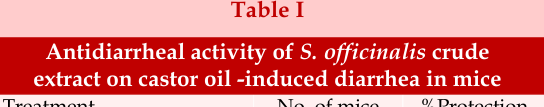
Antidiarrheal activity of S. officinalis crude extract on castor oil -induced diarrhea in mice Treatment No. of mice %Protection with diarrhea